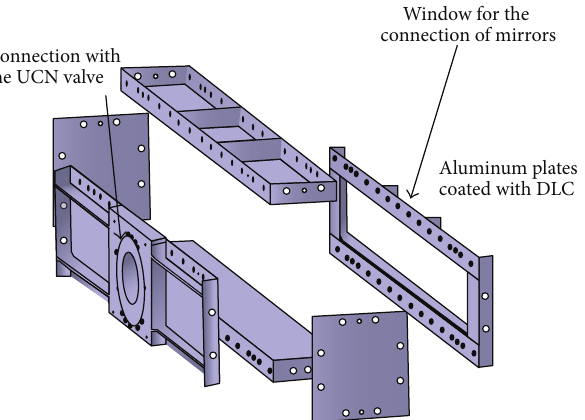
Figure 15: The DLC-coated storage volume. The inner sizes are 40× 40 × 340 mm 3 .